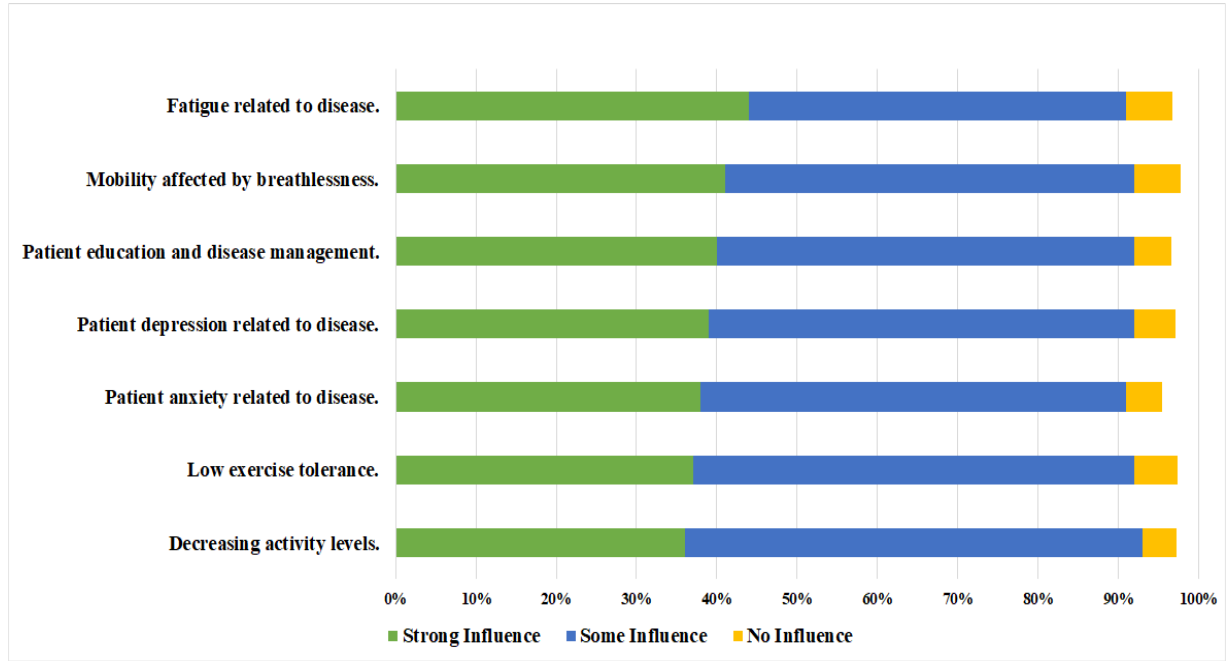
Figure 1. Patient-related factors that influence referral decision to cardiopulmonary rehabilitation, using strong, some, or no influence as a grading tool ( n = 439).